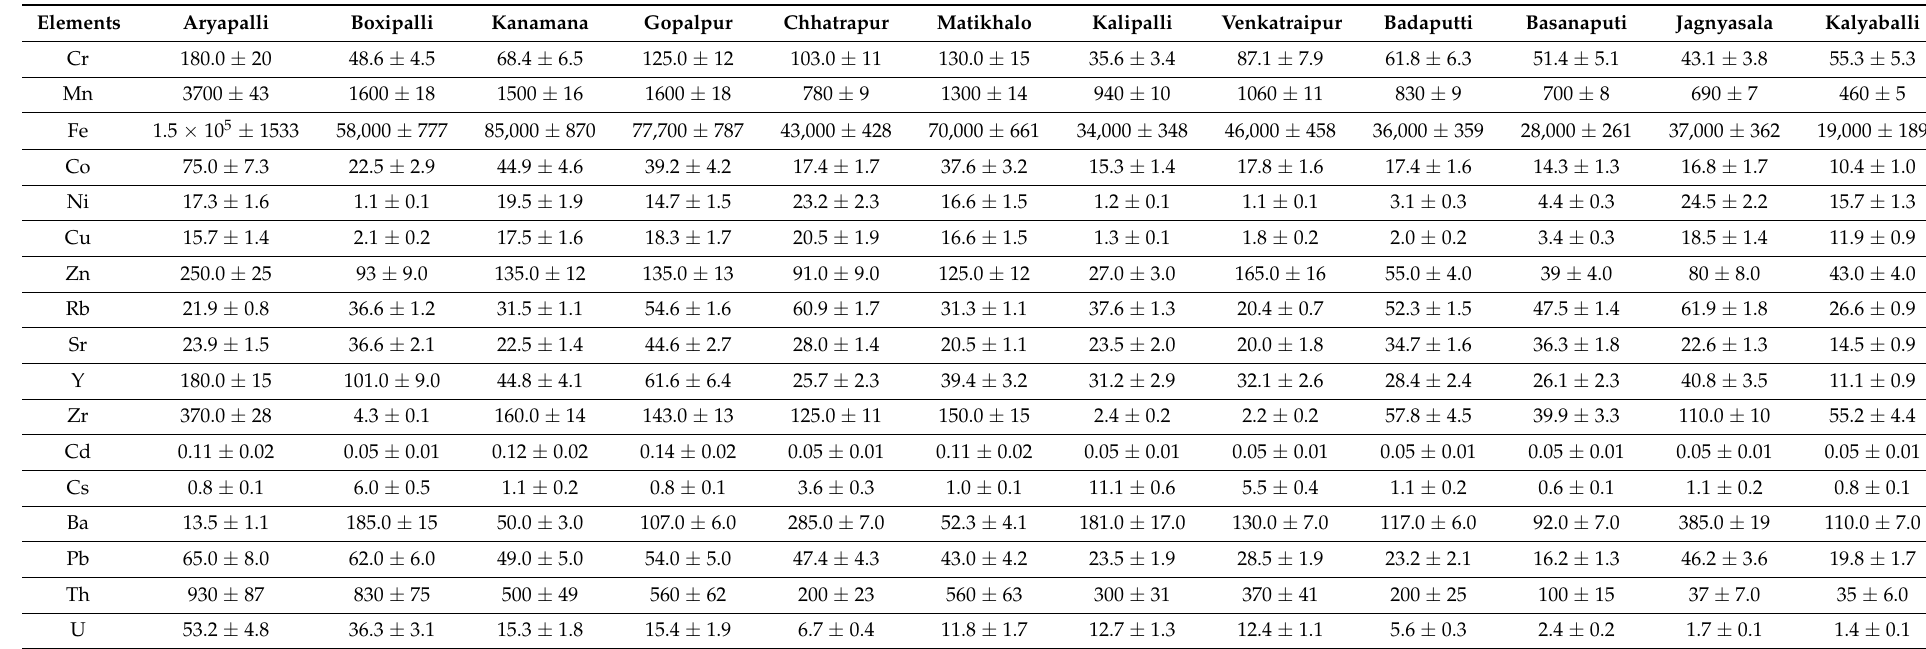
Table 2. Mean concentration ( µ g g − 1 ) of TEs in